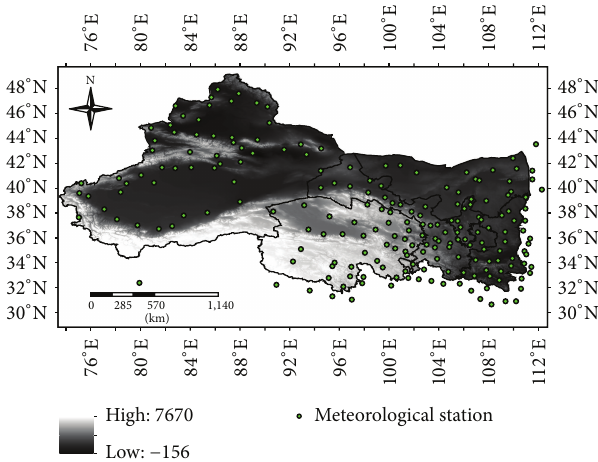
Figure 1: Locations of temperature and precipitation recording sta- tions in northwestern